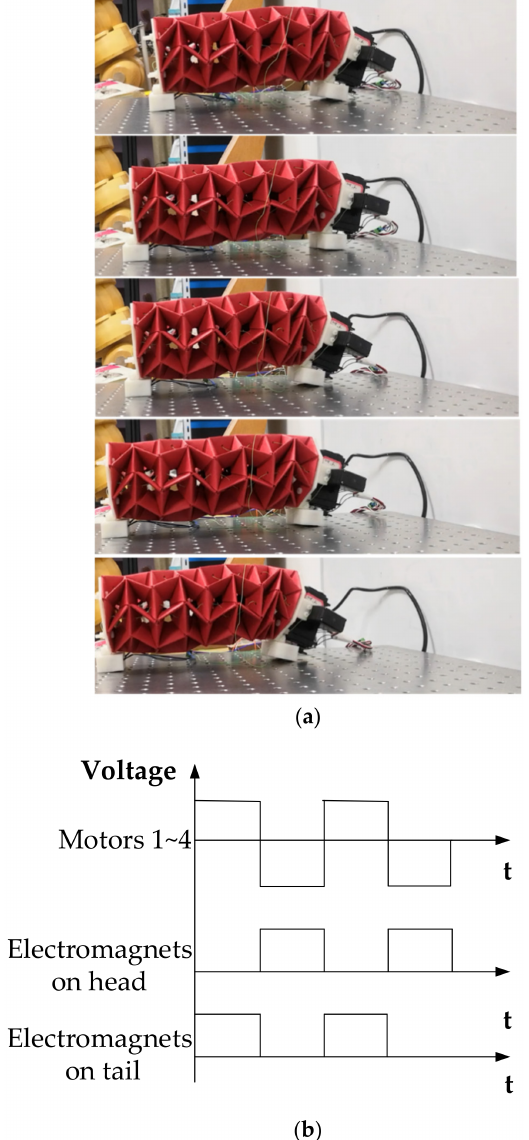
Figure 23. Origami crawling robot with electromagnetic sliding feet on an iron plane: ( a ) side view of backward motion; ( b ) control signals of motors and electromagnets of backward